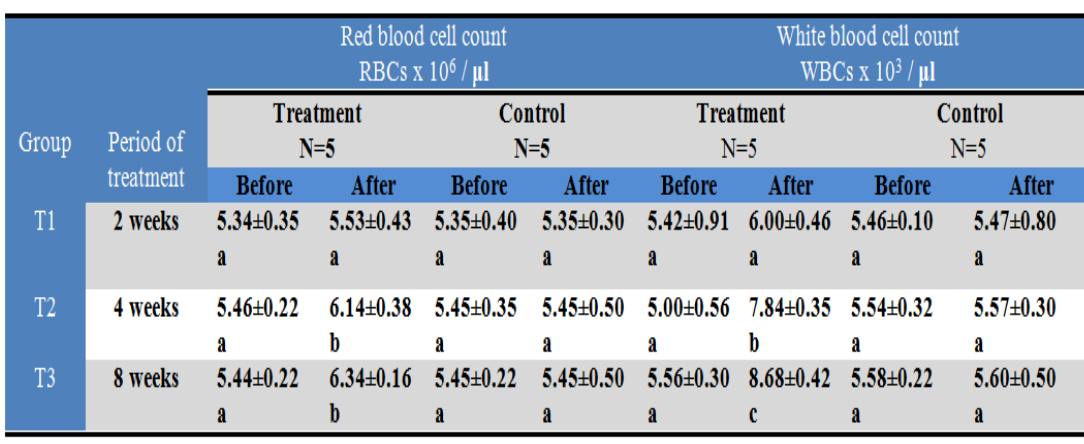
Table 4: Effect of orally administering a low dose (4.8 mg/kg/day) of Citrullus colocynthis on the red and white blood cells count of male rabbits in different